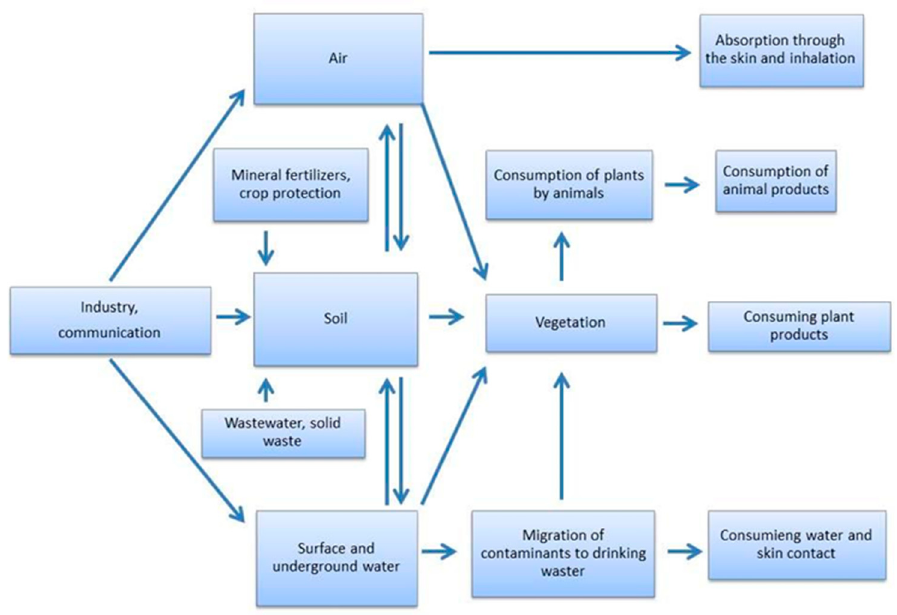
Figure 1. Schematic presentation of the possible transport of heavy metals in the environment.